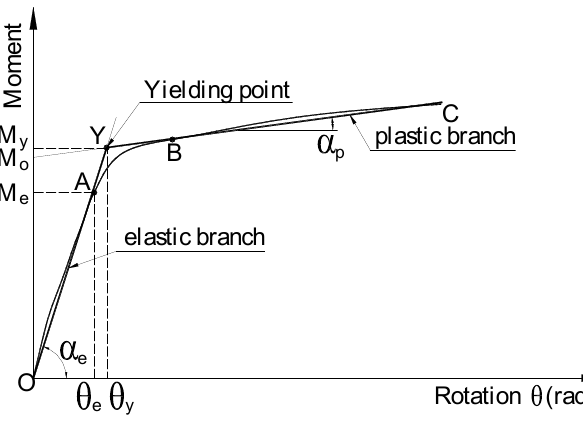
Figure 12. Idealized moment-rotation curve.